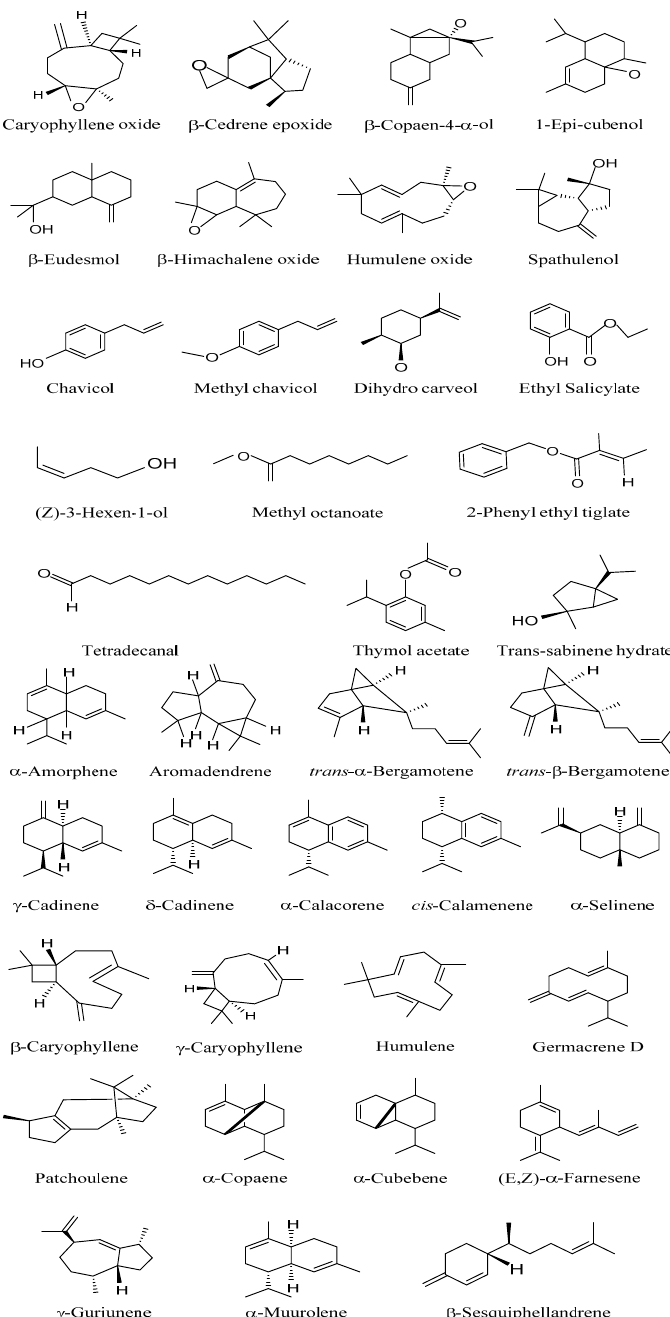
Figure 1. The structures of some of the volatile chemical constituents.